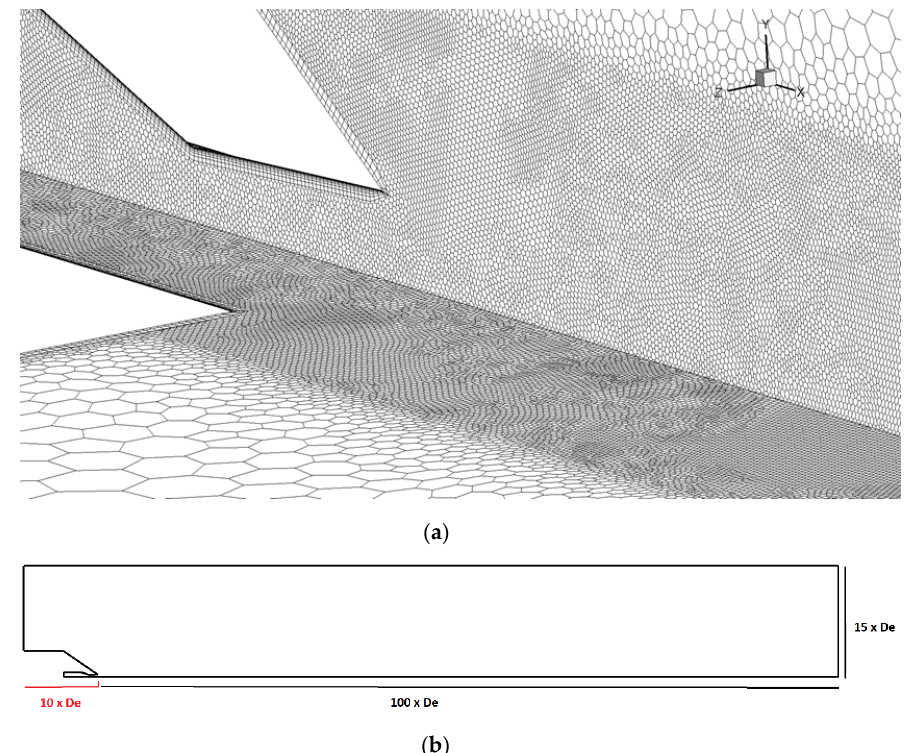
Figure 1. Mesh and computational domain—( a ) polyhedral mesh on minor and major axis symmetry planes for the baseline nozzle, ( b ) computational domain.